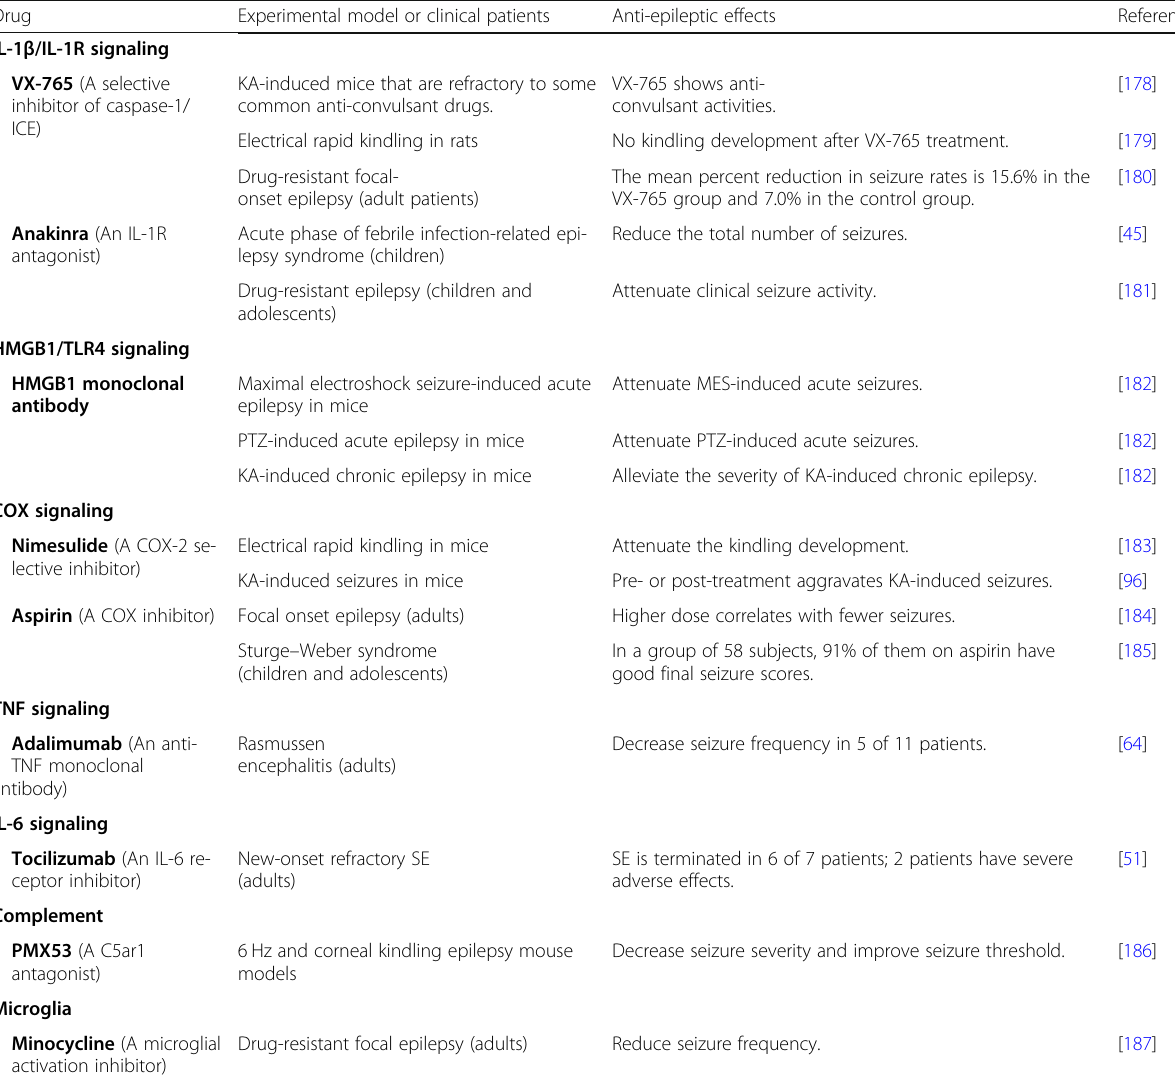
Table 3 Anti-epileptic effects of anti-inflammatory treatments in animal models or patients Drug Experimental model or clinical patients Anti-epileptic